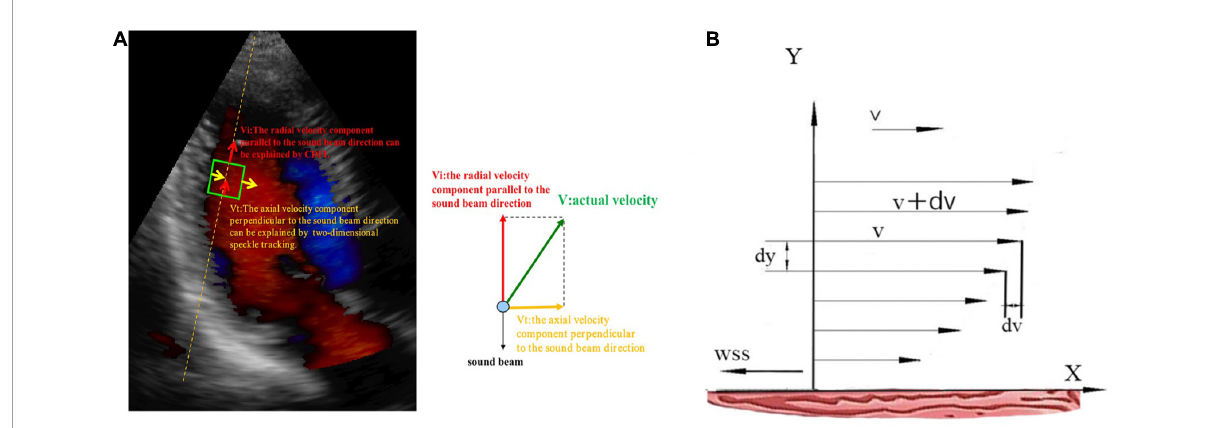
FIGURE3 (A) The blood flow vector of the left ventricle in the apical view. Vi, the blood flow vector parallel to the sound beam; Vt, the blood flow vector perpendicular to the sound beam; V, the actual blood flow vector. (B) X -axis, left ventricular wall; v, the flow velocity of a certain blood flow layer; v + dv, the flow velocity of adjacent blood flow layer; dv, the velocity difference; dy, the vertical distance between two flow layers; WSS, the direction of WSS is opposite to the direction of blood flow.